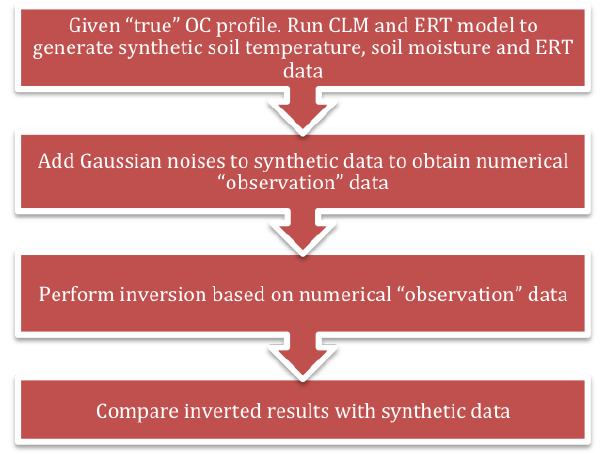
Figure 5. General procedure used to perform the synthetic case